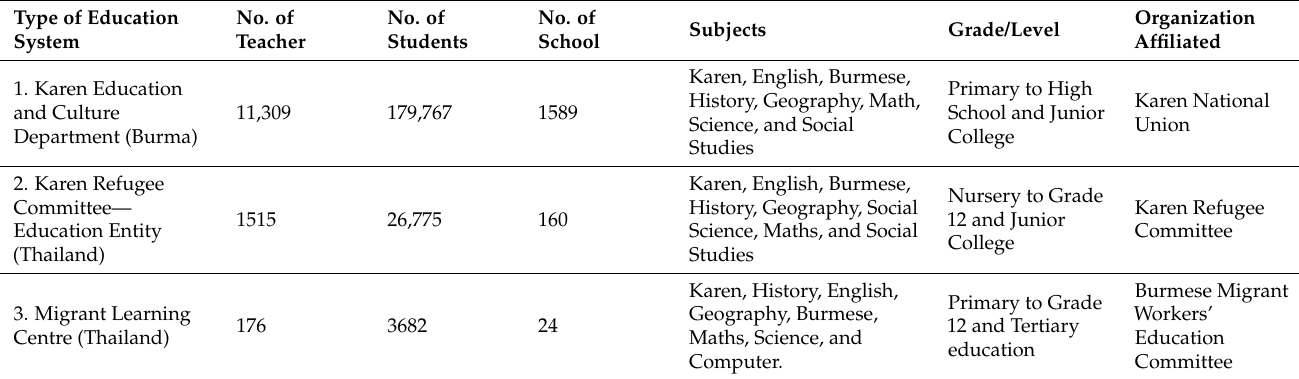
Table 1. Summary of three types of Karen education